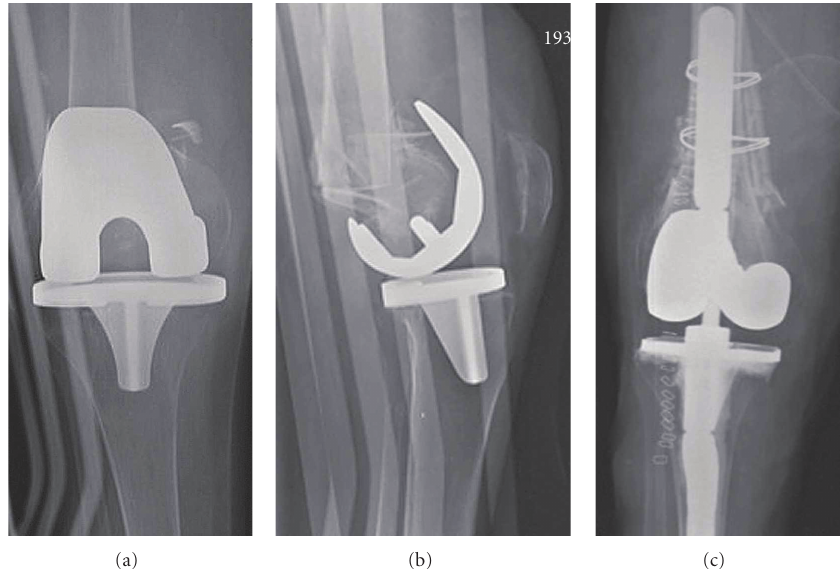
Figure 4: Radiograph showing a supracondylar periprosthetic fracture with major bone loss ((a) and (b)). An AP radiograph showing a revision with femoral allograft-implant composite